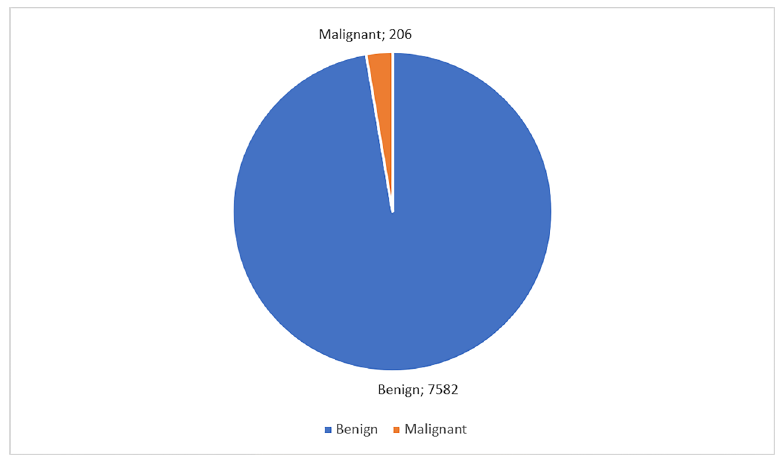
Figure 3. Chart showing the distribution of benign and malignant gall bladder diseases in North-Western India